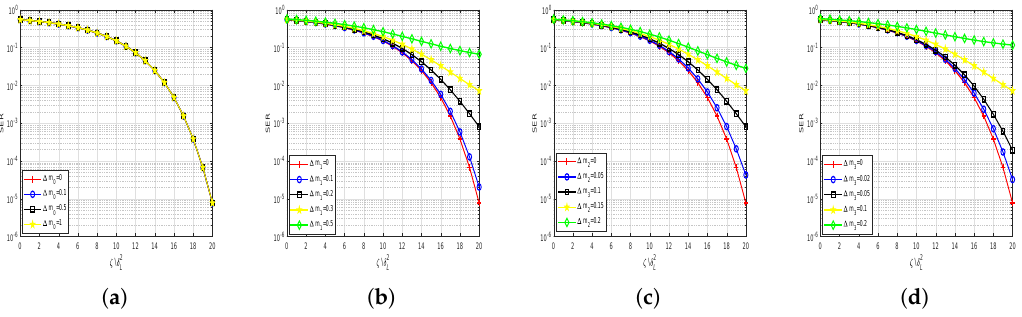
Figure 10. The anti-performance for proposed scheme on parameter m ( a ) ( α , m , c ) = ( 0.5, [ m 0 ,0,0,0 ] , [ 0,0,0,0 ]) , ( b ) ( α , m , c ) = ( 0.5, [ 0, m ( d ) ( α , m , c ) = ( 0.5, [ 0,0,0, m 3 ] , [ 0,0,0,0 ])